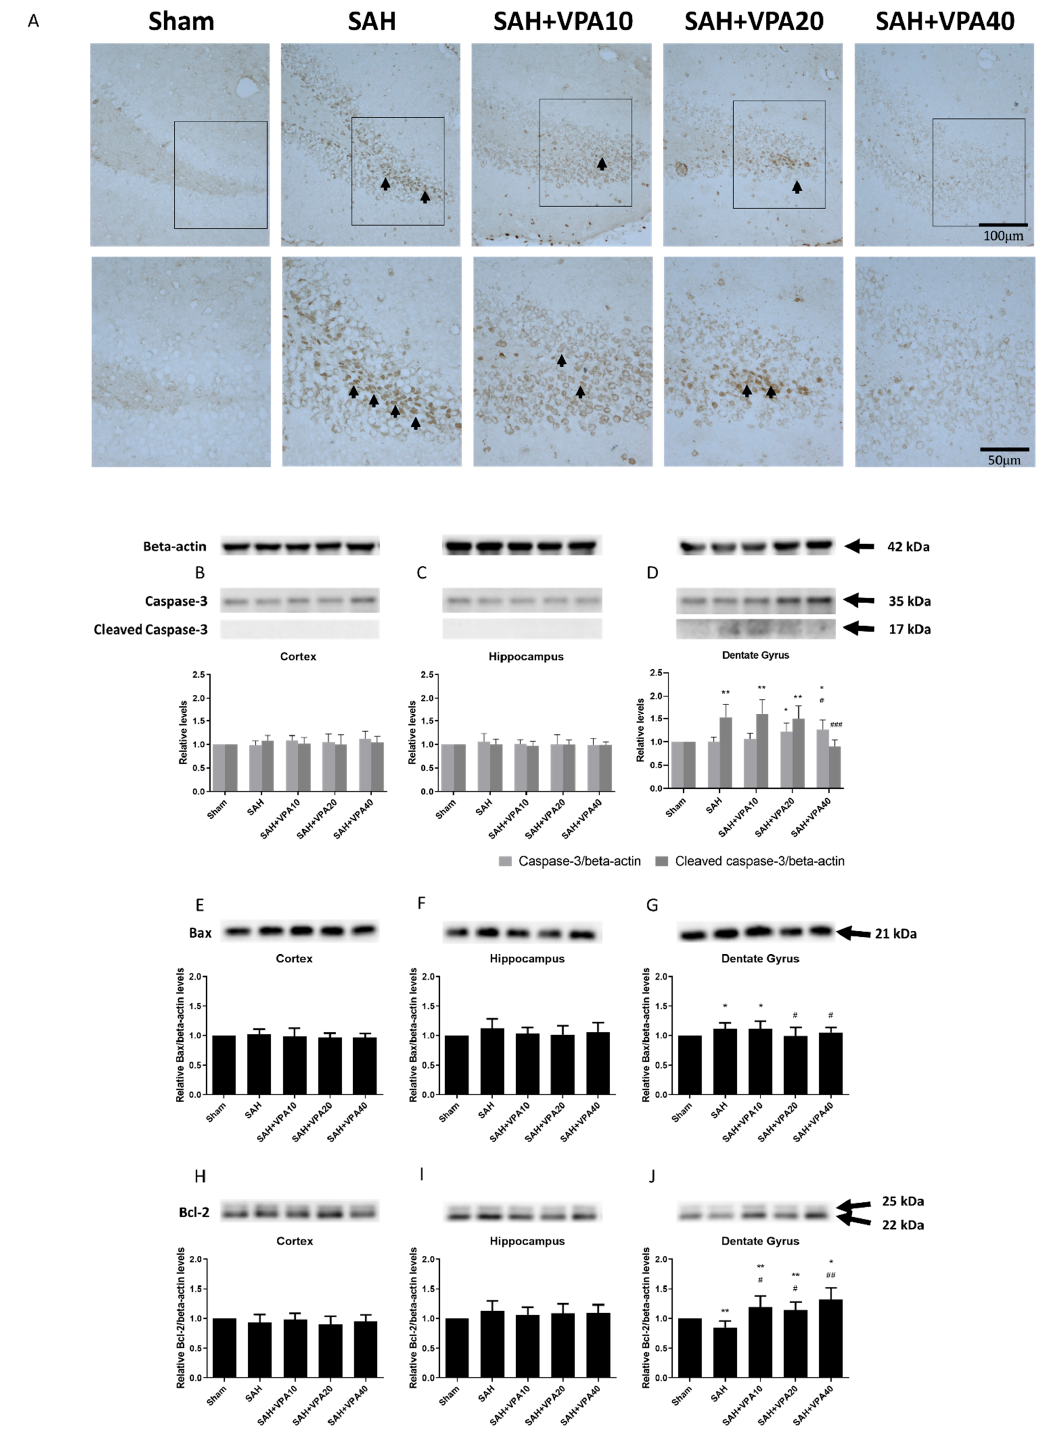
Figure 2. VPA reversed SAH-induced apoptosis signaling in dentate gyrus. ( A ) TUNEL labeling was used to identify apoptotic cells after SAH in response to VPA administration (scale bar = 100 µ m). SAH induced neuronal apoptosis in the dentate gyrus whereas VPA decreased apoptotic cells (black arrows). Black rectangle in top panels indicates the apoptotic cells for high magnifications in lower panels. (scale bar = 50 µ m) ( B – D ) Representative expression of caspase-3, cleaved caspase-3, ( E – G ) Bax and ( H – J ) Bcl-2. Beta-actin was used as control. All gels were run in the same experimental conditions ( n = 6). * p < 0.05, ** p < 0.01, compared with the sham group, # p < 0.05, ## p < 0.01, ### p < 0.001, compared with the SAH